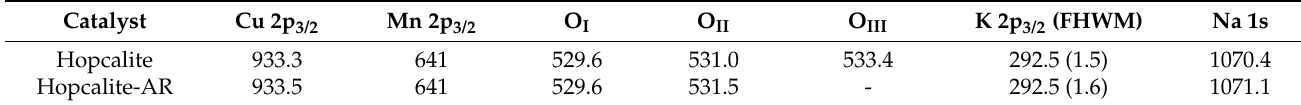
Table 6. Binding energy of the elements (eV).